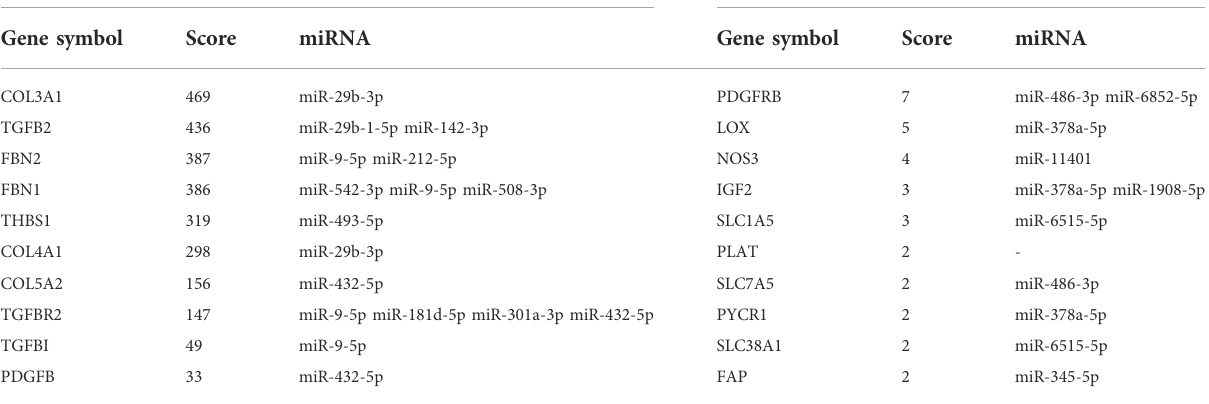
TABLE 4 Top 10 hub genes of the candidate genes in the PPI network ranked by